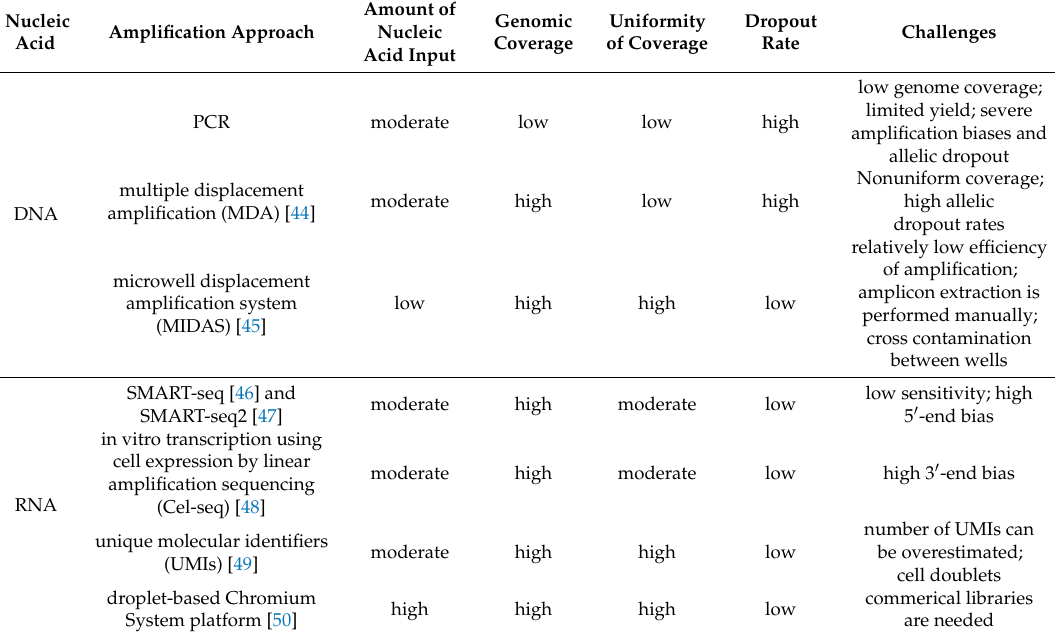
Table 2. Comparison of selected nucleic acid amplification approaches for single-cell